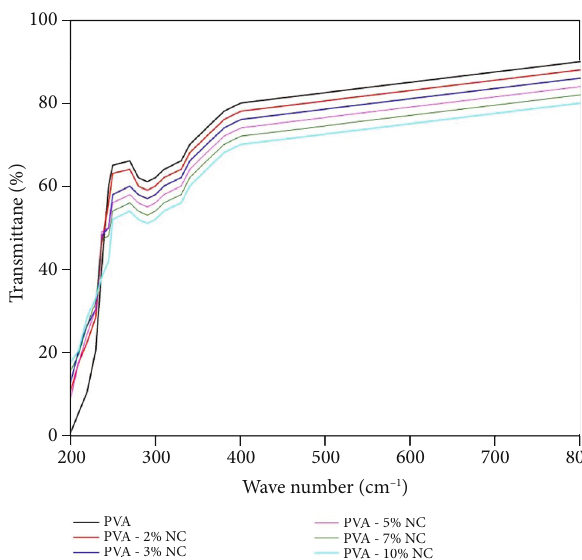
Figure 6: Biodegradability result of neat PVA and PVA-NC composite fi